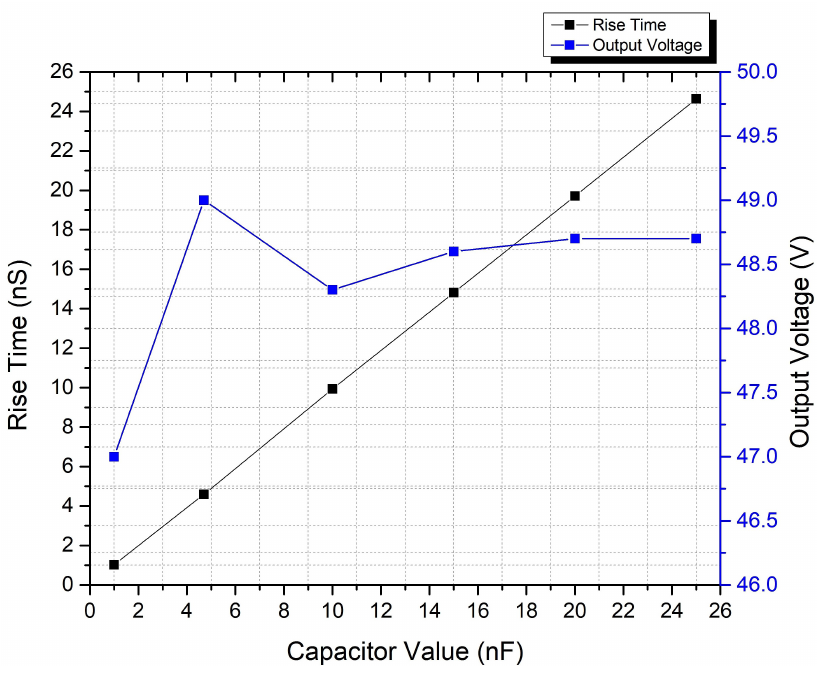
Figure 9. The transient response graph of the modified Marx generator circuit with an optocoupler. The transient analysis of the modified optocoupler circuit without the optocoupler is shown in Figure 10.